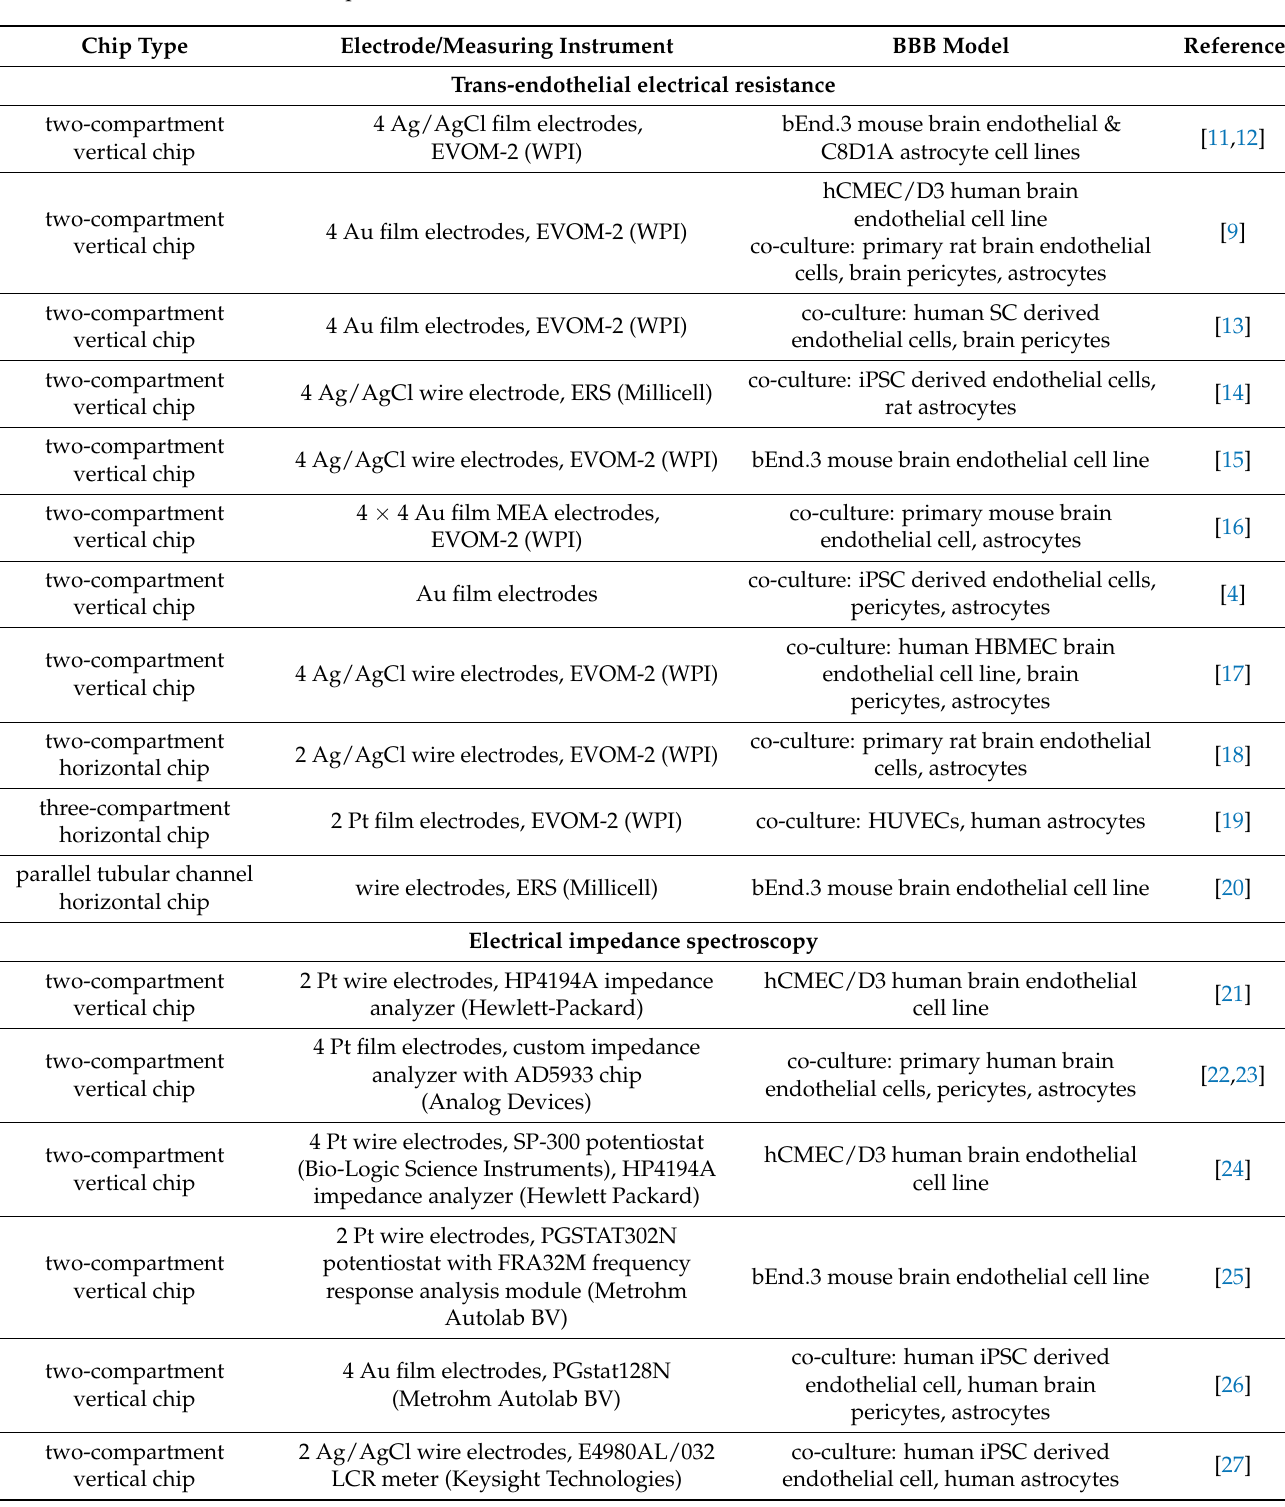
Table 1. Measurement of barrier integrity and cell surface charge of blood-brain barrier models on chip devices with electrical